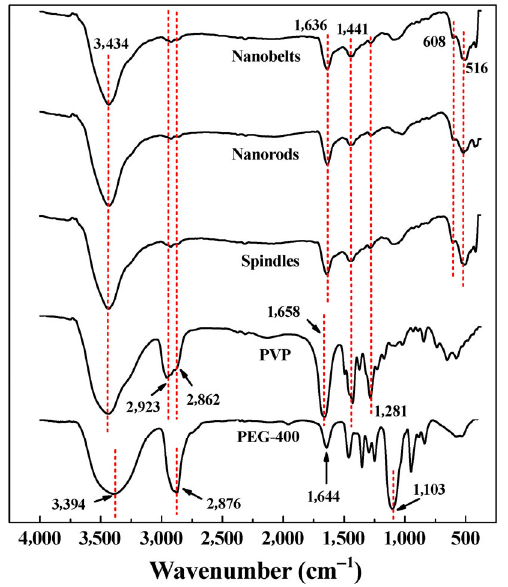
Fig. 5 Representative XRD patterns of the CuO nanostructures with different morphologies.